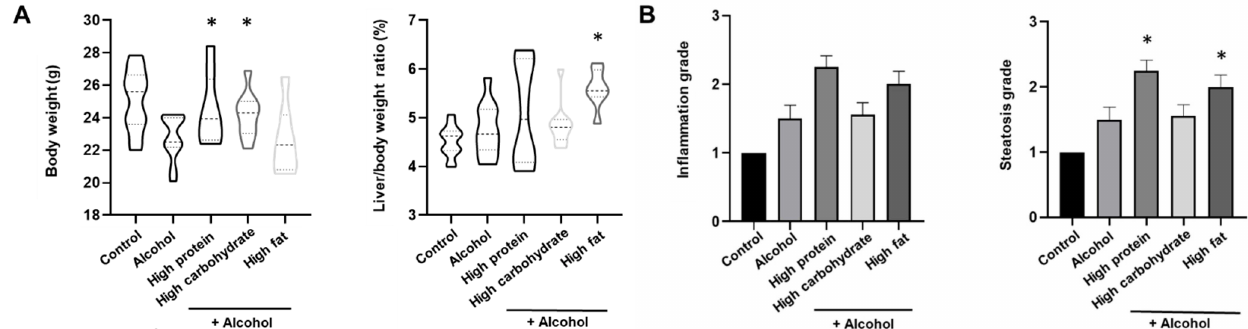
Figure 2. Pathological result according to diet group. ( A ). Liver/Body weight ratio (%), violin plot with min and max score